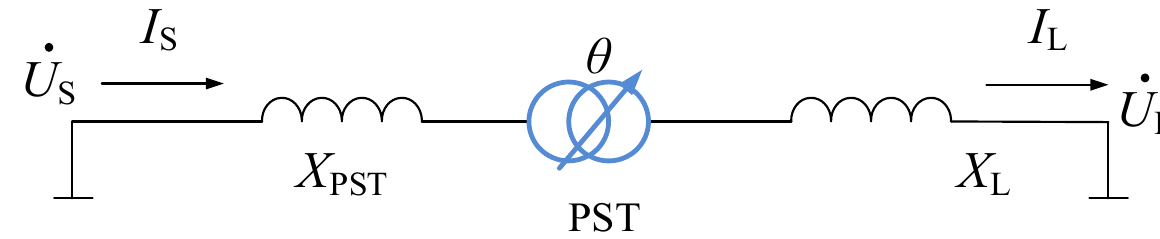
Figure 1. Equivalent model of PST in transmission line .